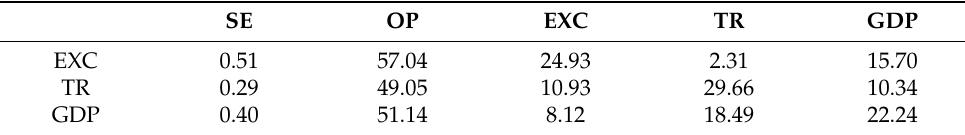
Table 4. Variance Decomposition: Average of 12 periods.